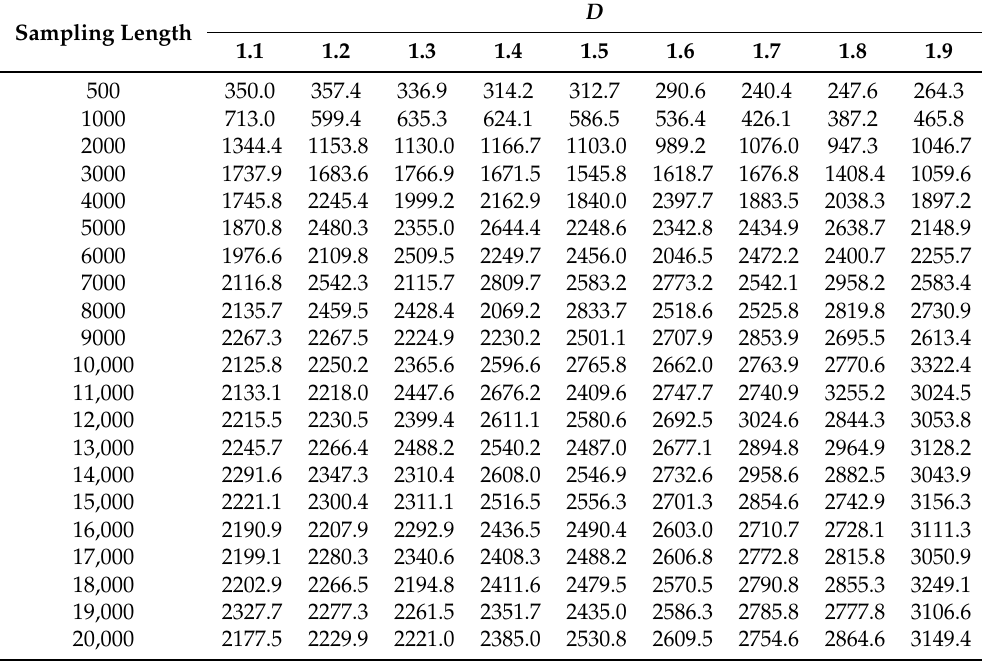
Figure A1. The typical fractal profiles generated by using the W-M function. Table A1. Under all sampling lengths and all fractal dimensions, L c of corner points under the condition of 0-order flattening